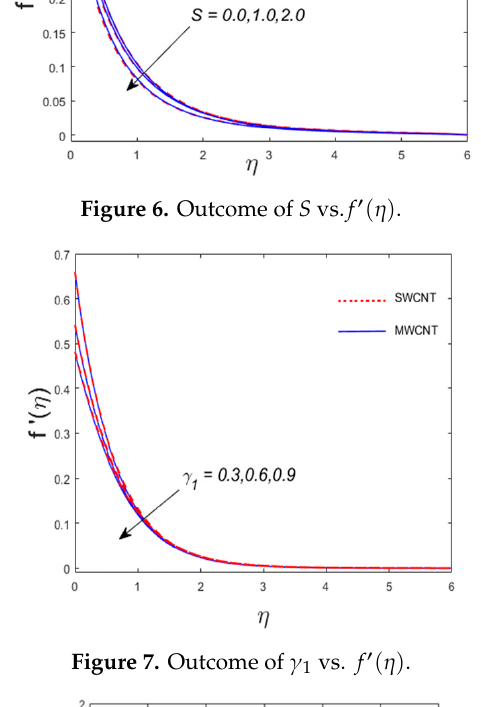
γ vs. 𝑓′(𝜂) . 1 γ vs. 𝑓′(𝜂) . 1